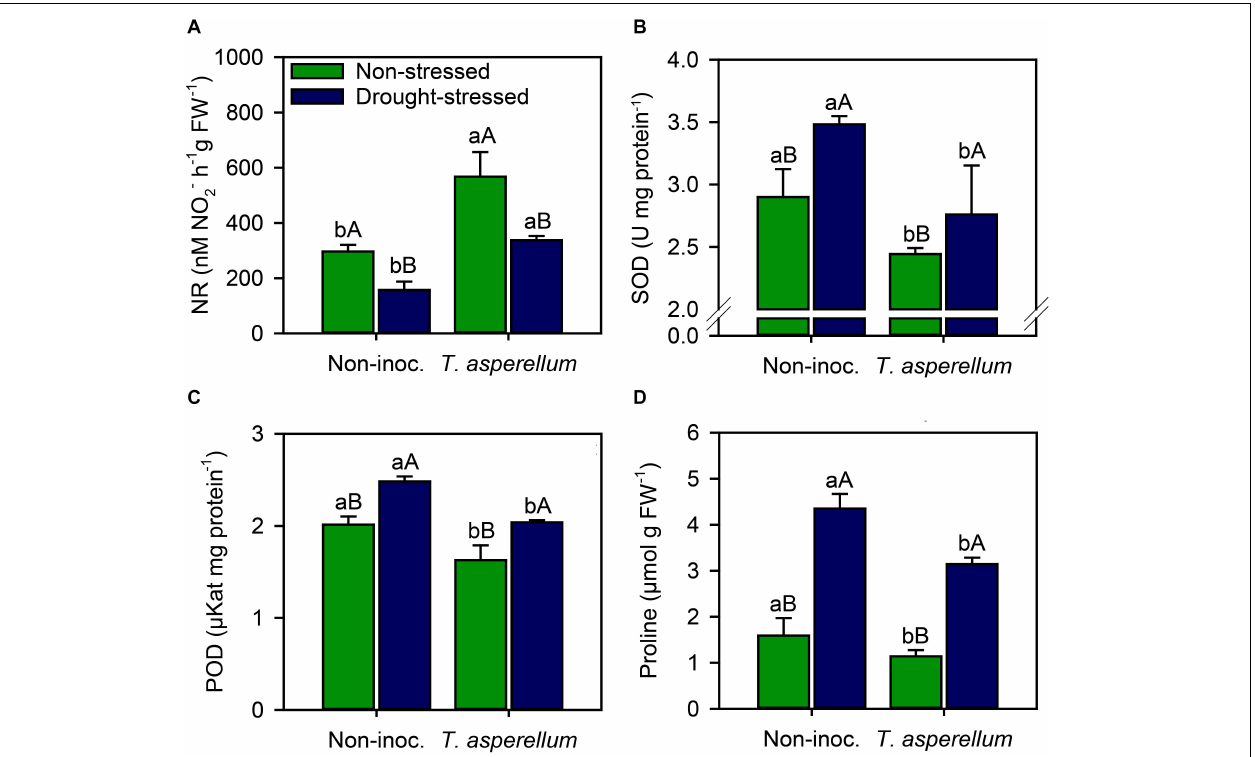
FIGURE 4 | Activities of nitrate reductase (A) , superoxide dismutase (B) , peroxidase (C) , and proline concentrations (D) measured in sugarcane leaves according to the treatments. Different lowercase letters indicate significant differences between presence and absence of moderate drought stress, and different capital letters indicate significant differences between presence and absence of inoculation with T. asperellum by Fisher’s protected LSD test at p ≤ 0.05. Error bars express the standard error of the mean ( n = 4).